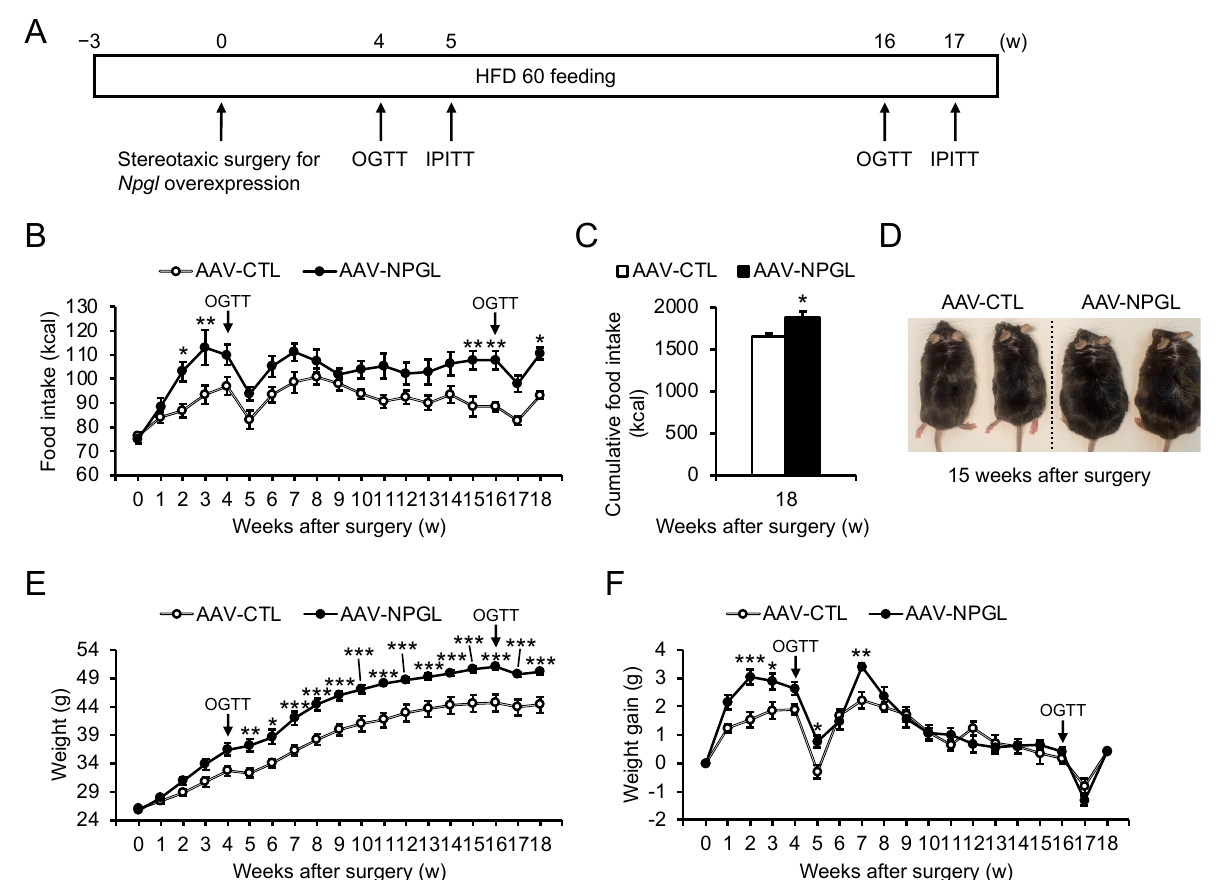
Figure 1. Effects of Npgl overexpression on weight gain and food intake in mice fed a high-fat diet with 60% calories from fat (HFD 60). These mice were injected with an adeno-associated virus (AAV) vector, either a control (AAV-CTL) or a vector carrying the NPGL precursor gene (AAV-NPGL). ( A ) Experimental procedure. Mice were subjected to the first oral glucose tolerance test (OGTT) and the first intraperitoneal insulin tolerance test (IPITT) at 4 and 5 weeks after surgery, respectively. Thereafter, mice were subjected to the second OGTT and IPITT at 16 and 17 weeks after surgery, respectively. ( B , C ) Weekly ( B ) and ( C ) cumulative food intake over 18 weeks. ( D ) Representative photograph of mice placed on HFD 60 at 15 weeks after injection of AAV-CTL or AAV-NPGL. ( E ) Weight. ( F ) Weekly weight gain. Statistical analyses were performed using two-way repeated measures ANOVA followed by Bonferroni’s test ( B , E , F ) or Student’s t -test ( C ). Each value represents the mean ± standard error of the mean (AAV-CTL: n = 8, AAV-NPGL: n = 8; * p < 0.05, ** p < 0.01, *** p < 0.005).